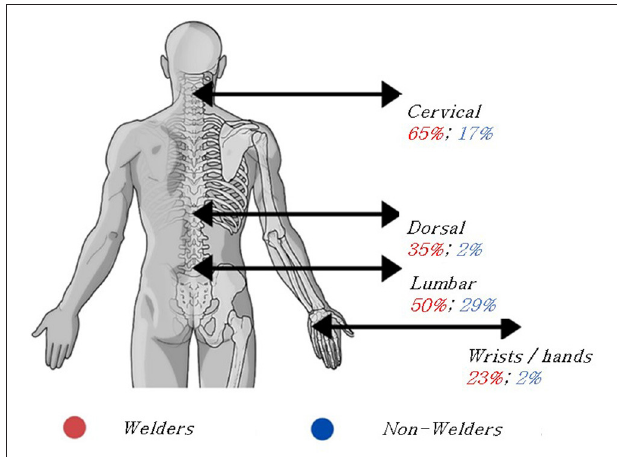
FIGURE 1 | Percentage of incidence of symptoms of musculoskeletal disorders in the areas that were significantly different between welders and non-welders.